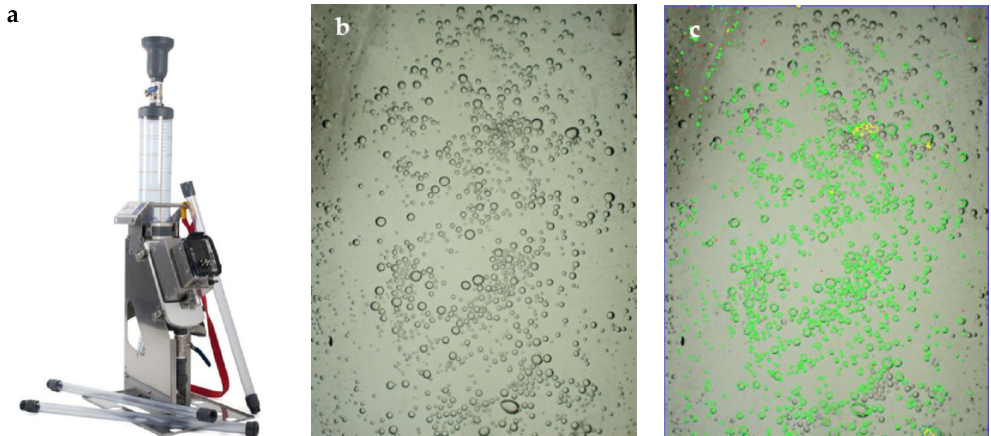
Figure 3. ( a ) APBS probe, ( b ) captured bubble images and ( c ) bubble segmentation, image size 91 × 69 mm.